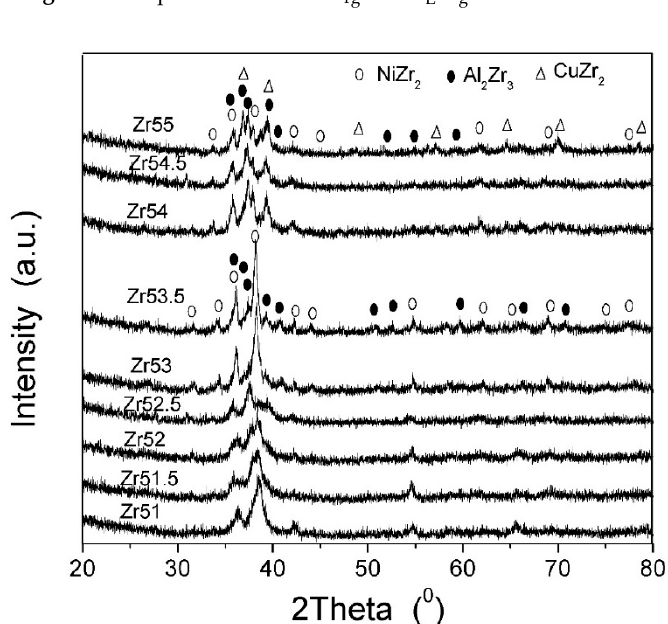
Figure 14. XRD patterns for the studied Zr-based BMGs subjected to DSC test at a heating rate of 80 K ∙ min − 1 .